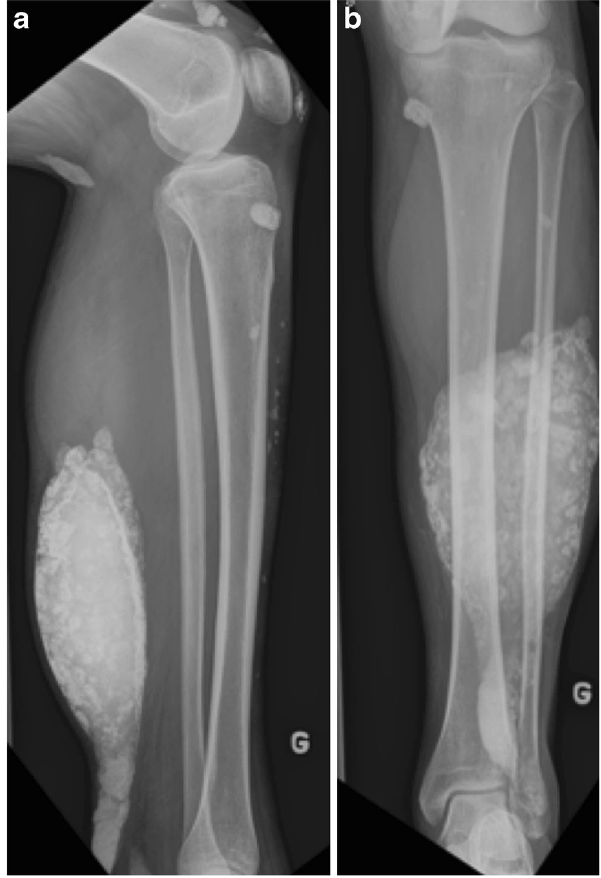
Fig. 20 Dermatomyositis. ( a ) Lateral and ( b ) frontal radiographs of the left leg show sheet-like muscular calcifications in a case of dermatomyositis